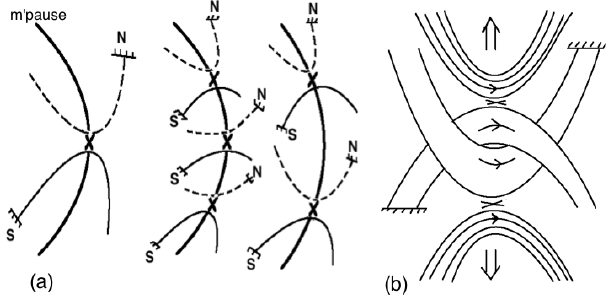
Fig. 4. (a) Sketch of the three steps in the X point configurations for the magnetic topology evolution in Fig. 9. The left panel in the sketch is the configuration for the topology shown at t = − 30 and − 15s (first two panels in Fig. 9), the middle sketch refers to t = 0 (middle panel) and the sketch on the right to t = 15 and 120s (two panels on the right). The m’pause line refers to the magnetopause and the Xs to the X points. The full and dashed lines are the re- connected magnetic field lines coming out from the reconnection site, and connected to Earth’s Southern (S) and Northern (N) Hemi- spheres. (b) Sketch illustrating the structure of two interlinked flux tubes. We show magnetic field lines and tubes on the magnetopause seen from the Sun. The Xs indicate the two possible reconnection sites responsible for such magnetic field